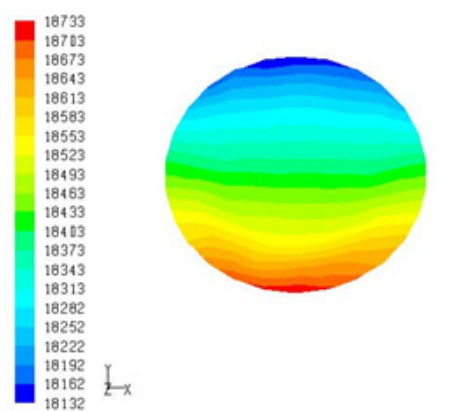
Fig. 2-3. Uneven inlet pressure field (water level of 0.16 m).